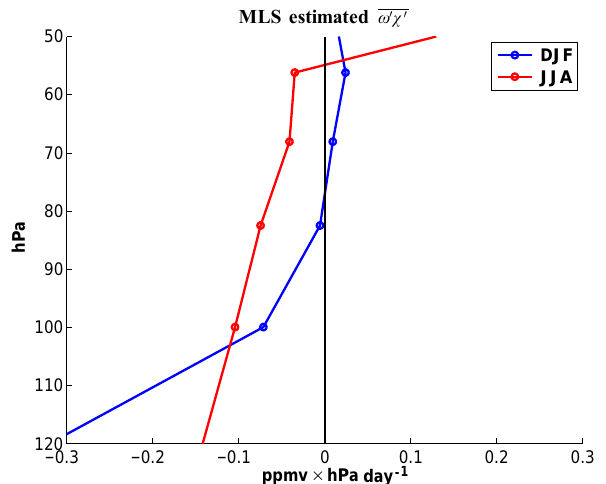
Figure 9. The estimated vertical eddy flux of water vapor based on the difference in MLS effective vertical transport velocities between pressure and isentropic coordinates (see text for